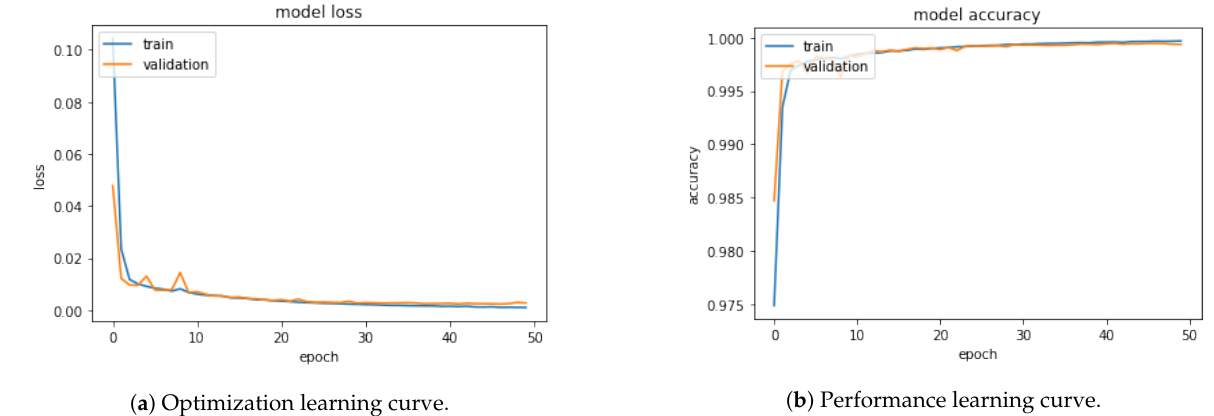
Figure 12. LSTM training and validation learning